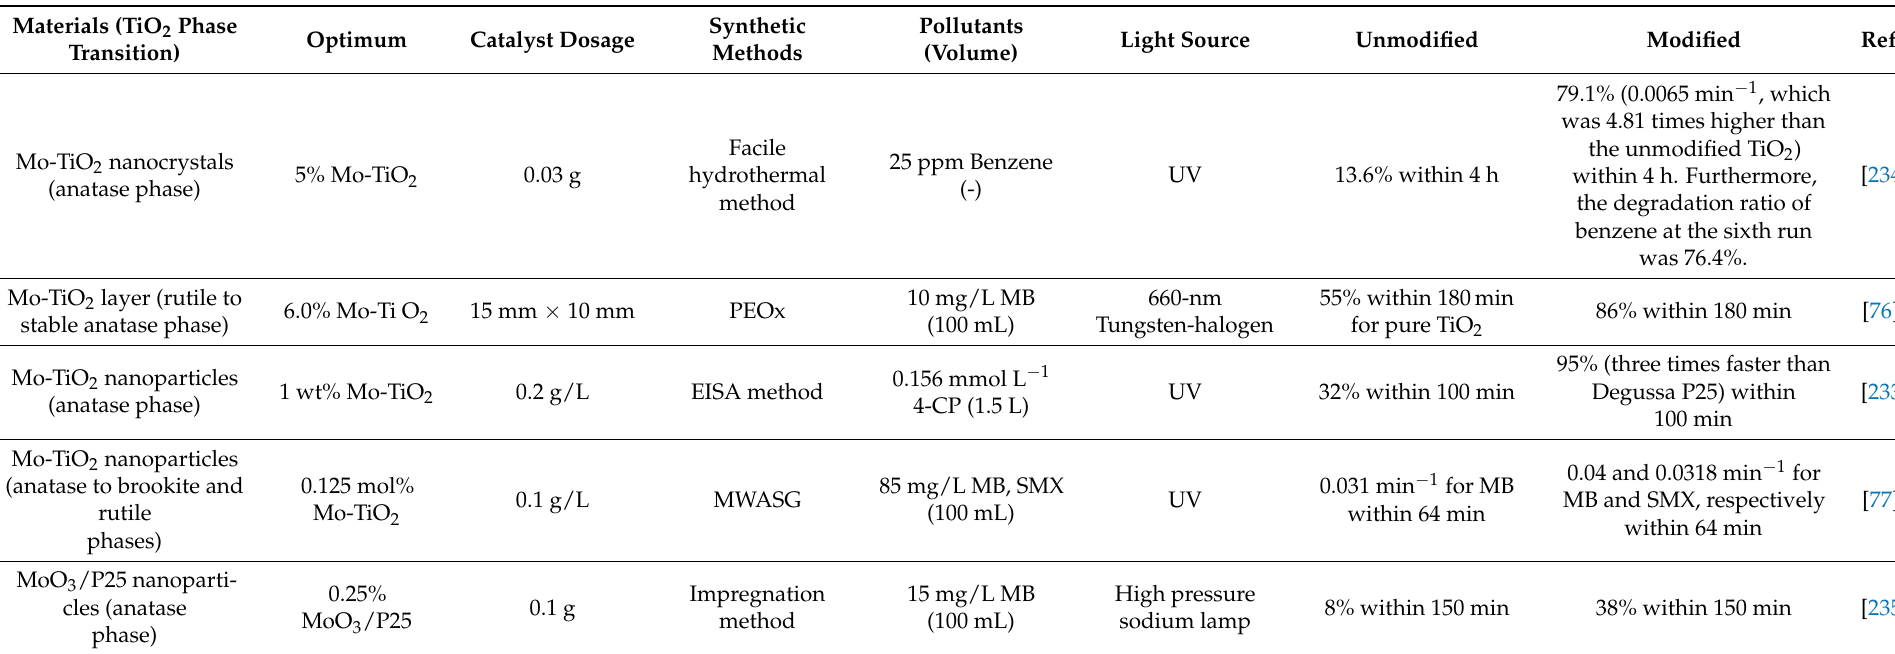
Table 10. Summary of recent progress on Mo-TiO 2 photocatalysts for organic pollutants